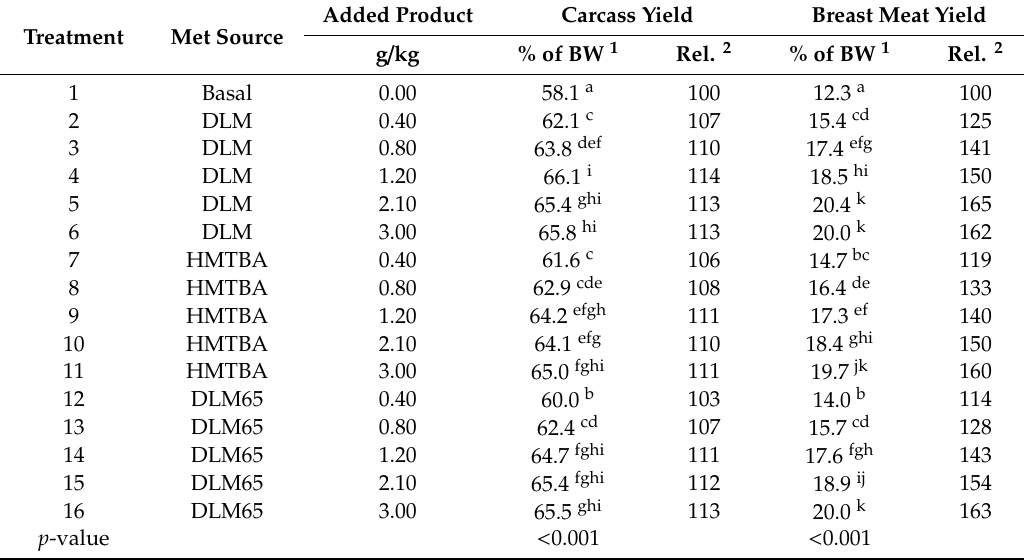
Table 4. E ff ect of increasing levels of Met sources on carcass yield and breast meat yield expressed as percentage of body weight at 35 days of